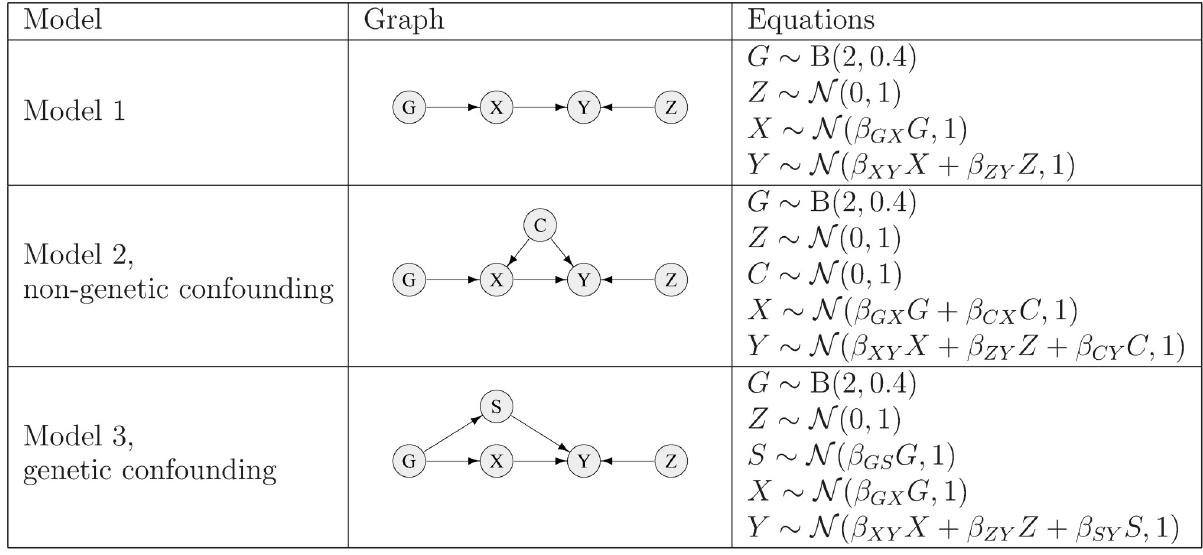
Fig 2. Simulation models used in simulation study 1 of quantitative trait data. Data were simulated for two continuous variables (X and Y), together with a genetic instrument G (coded as 0, 1, 2) and a continuous instrumental variable Z. Parameter values for models involving weak confounding were chosen as β GX = 0.1, β ZY = 0.075 and β CX = β CY = β GS = β SY = 0.25. For models involving strong confounding, the parameter values were the same except that β = β = β = β = 0.5 i.e. the parameters controlling the confounding effects were doubled. The parameter β CX CY GS SY 0.1, 0.2, 0.3, 0.4 and 0.5. For the calculations where false positives were counted as detections of an arrow between X and Y in the wrong direction, the direction of causality was reversed between X and Y , such that for model 1 the equations become X � N ð b β YX varied using values of 0.1, 0.3 and 0.5 (and similarly for models 2 and 3).